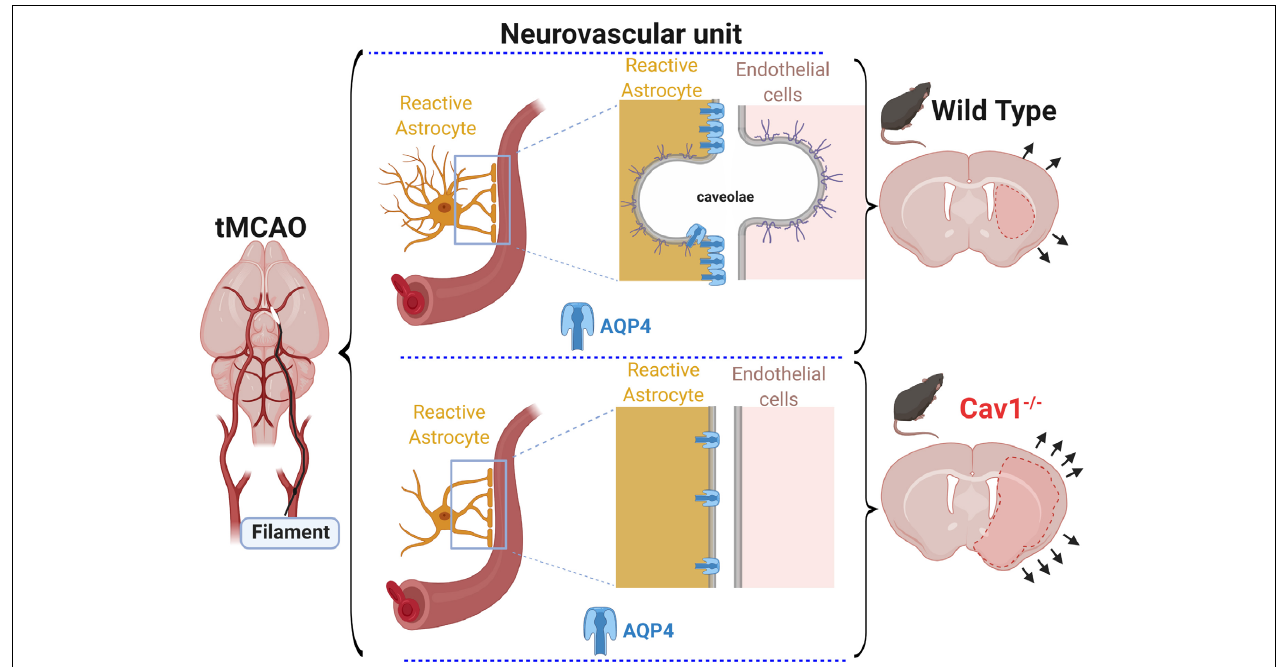
FIGURE 4 | After transient filament MCAO (left), Cav 1 KO mice had larger lesions, enhanced cerebral edema and higher hemispheric swelling (bottom right) compared to WT mice (top right). At the level of the NVU (center images), the absence of caveolae* and Cav-1 correlated with altered astroglial reaction and expression of AQP4 on astrocytic end-feet in Cav-1 KO mice (bottom center) compared to WT mice (top